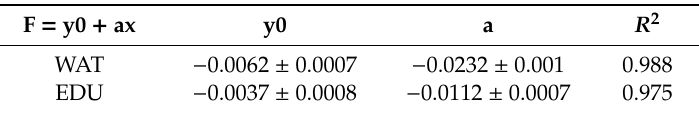
Table 3. Results of the polynomial equation (f = y0 + ax) to the RP (recovery phase) extracted from daily course of sap flow (S f , independent variable) plotted against changes in stem water deficit ( ∆ W i ) in WAT (water treated) and EDU (EDU treated) trees ( ± SE, N = 5 trees). f, polynomial function; y0, y-value for x = 0; a,